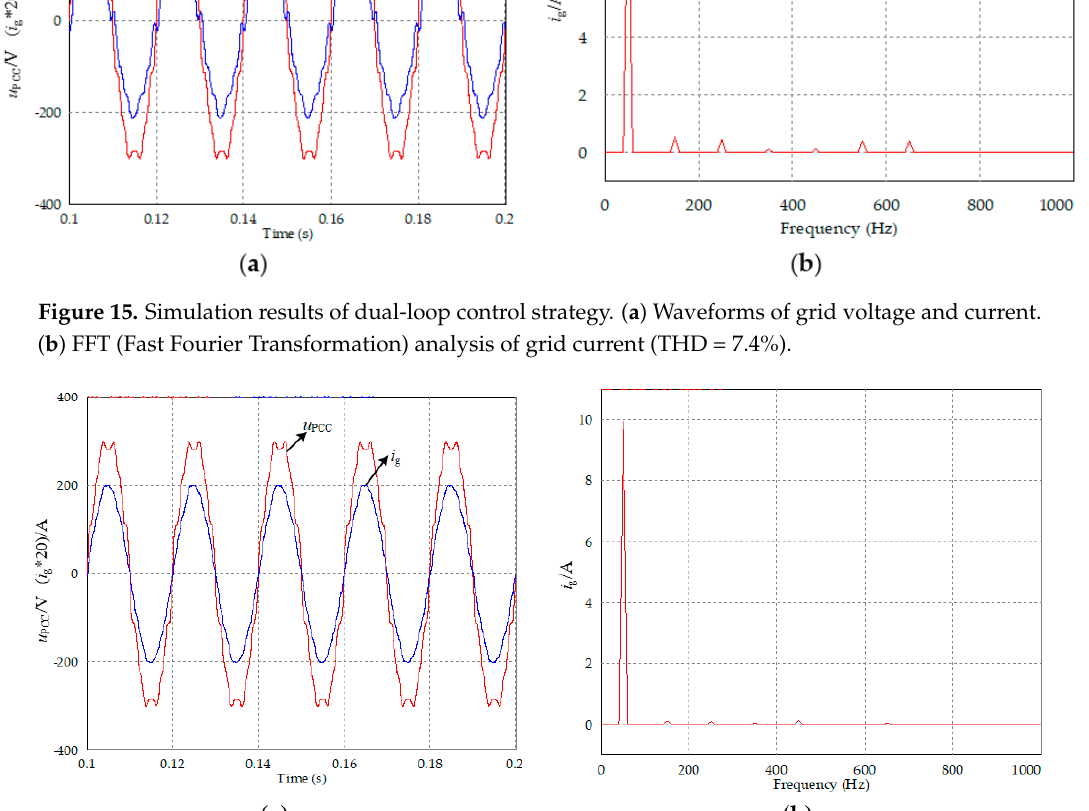
Figure 16. Simulation results of grid voltage feedforward control strategy. ( a ) Waveforms of grid voltage and current. ( b ) FFT analysis of grid current (THD = 3.3%).